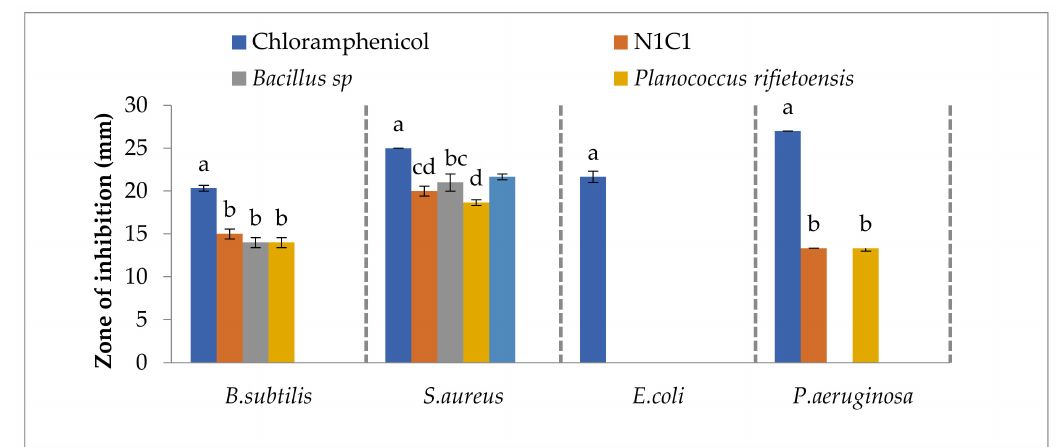
Figure 5. Antibacterial activity of Bacillus sp., Planococcus refietoensis , N1C1, and Arthrobacter sp. against pathogenic strains Bacillus subtilis, Staphylococcus aureus, Escherichia coli and Pseudomonas aeruginosa . Different letters are indicating significant differences ( p < 0.05) among treatments.